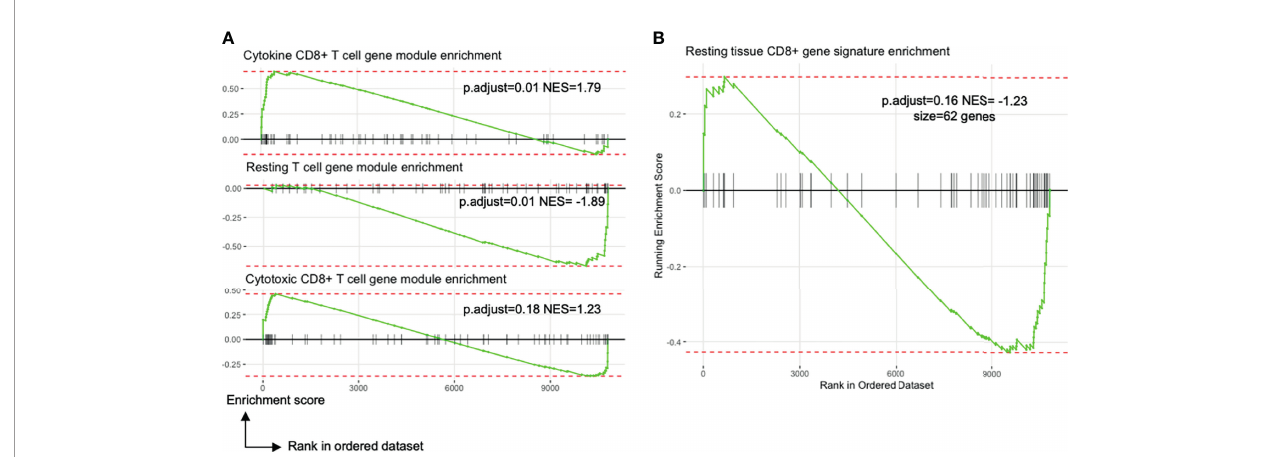
FIGURE 4 | Blood TRM-like cells may not be only activated memory T cells. All plots show the comparison of liver TRM and blood TRM-like cells (see Figure 2A ). (A) Enrichment plots of gene expression modules related to T cell transcriptional states identi fi ed by Szabo and colleagues. The CD8+ cytokine module includes genes encoding chemokines and cytokines (CCL3, CCL4, CCL20) and inhibitory molecules (LAG3, CD226, HAVCR2). The resting T cell module involves genes important for CD4+ and CD8+ T cell survival in blood and in tissues. The CD8+ cytotoxic module includes genes associated with cytotoxicity (GNLY, GZMK) and transcription factors associated with effector/memory differentiation (ZEB2, EOMES, ZNF683). NES is the enrichment score normalised to the mean enrichment of random samples of the same size. (B) Enrichment plot of a tissue CD8+ T cell signature identi fi ed by Szabo and colleagues (23). The complement of genes is derived by differential expression analyses between resting CCL5++ CD8+ memory T cells from several tissues compared to blood. FDR, false discovery rate; FNA, fi ne needle aspirate; GSEA, gene set enrichment analysis; GTPase, guanosine triphosphate hydrolase; MHC, major histocompatibility complex; ORA, over- representation analysis; p.adjust, Benjamini-Hochberg adjusted p value; PBMC, peripheral blood mononuclear